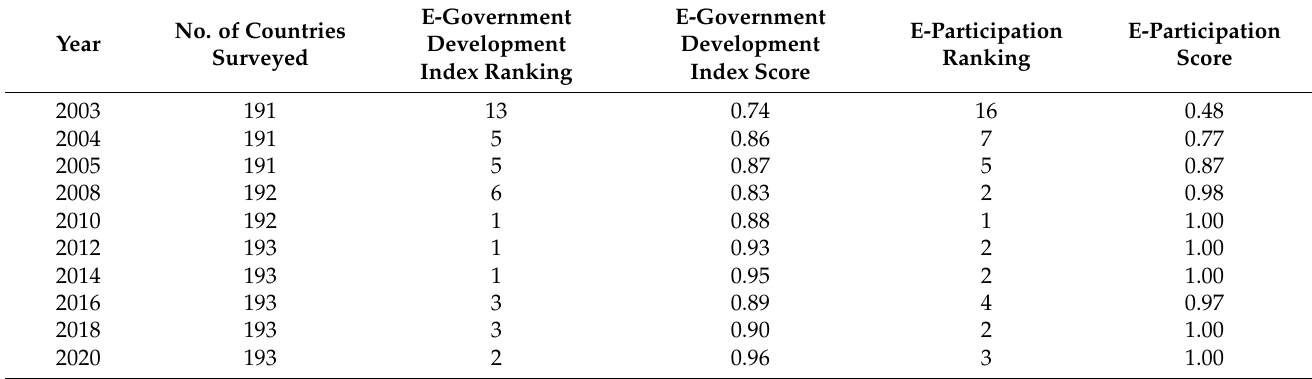
Table 1. Korea: Rankings and Scores in the UN E-Government Survey